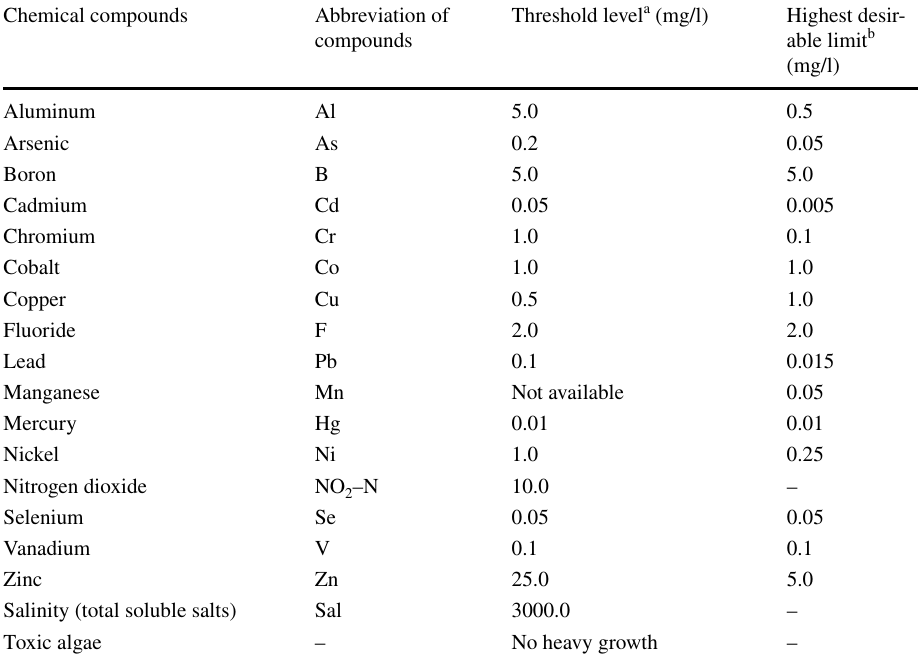
Table 9 Safe concentrations of some potentially toxic nutrients and contaminants in water for